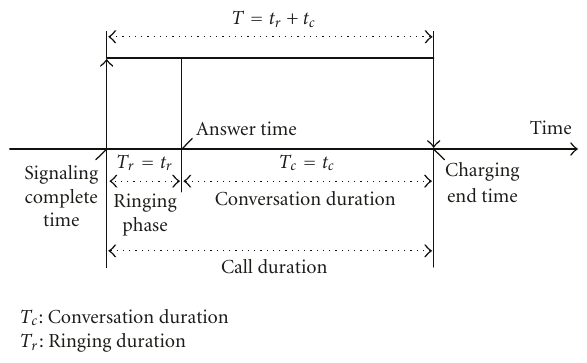
Figure 2: Time diagram to describe call